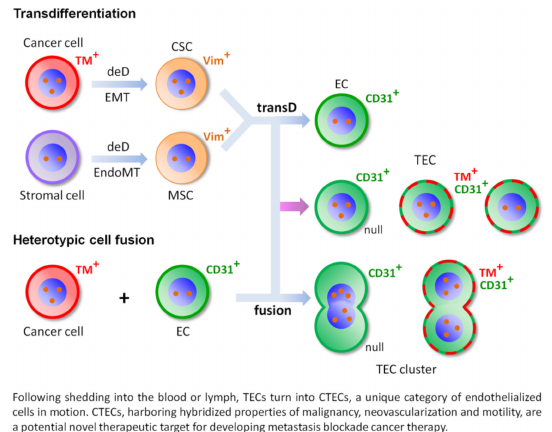
Figure 1. Schematic diagram of transdi ff erentiation and heterotypic cell fusion. Aneuploid tumor-derived endothelial cells (TECs) and circulating tumor-derived endothelial cells (CTECs) in carcinoma patients are primarily contributed by transdi ff erentiation and heterotypic cell fusion. ( A ) Transdi ff erentiation (transD). Di ff erentiated aneuploid cancer cells and stromal cells dedi ff erentiate (deD) into Vimentin + (Vim + ) mesenchymal cancer stem cells (CSCs) and mesenchymal stromal cells (MSCs) via epithelial-to-mesenchymal transition (EMT) and endothelial-to-mesenchymal transition normal diploid CD31 + endothelial cells (ECs, top blue arrow) and / or aneuploid TECs (middle pink arrow) having either a positive expression of tumor markers (TMs) (red / green dash ring, diploid or aneuploid) or not (null, aneuploid, green). Among MSCs, some EC-derived MSCs may di ff erentiate